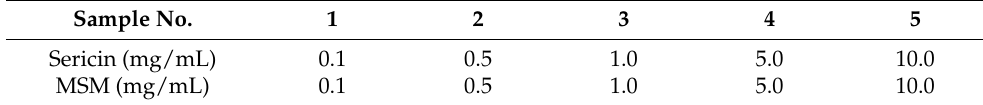
Table 1. Sericin and MSM concentrations.